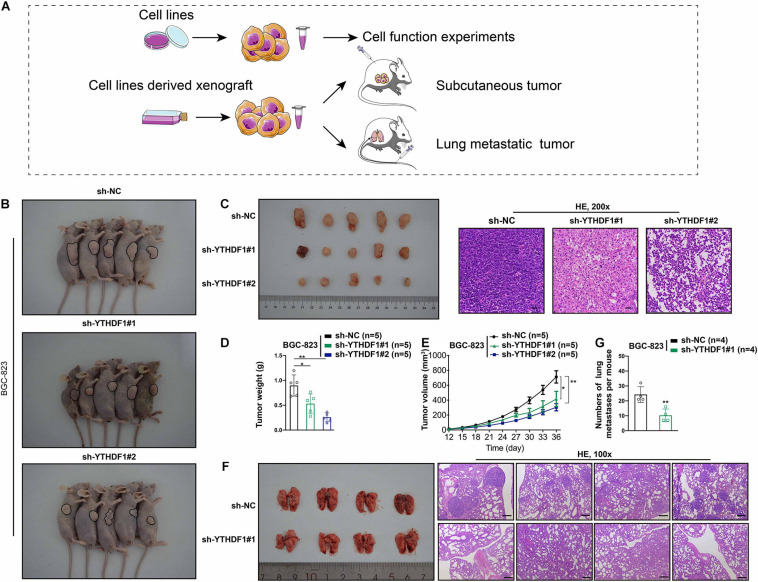
YTHDF1 deficiency inhibits tumor growth and metastasis in vivo. (A) Different systems were applied including GC cell lines and cell line-derived xenograft. (B) Images of the sacrificed nude mice injected with YTHDF1 deficient BGC-823 cells and its control group in mice subcutaneous tumor model (n = 5). (C) (Left) Tumors were dissected from the nude mice of each group and photographed at 36 days after transplantation. (Right) Representative histology images in mice subcutaneous tumor model (n = 5, 200×). Scale bar, 50 μm. (D,E) Tumor weight and the tumor growth curve were measured in YTHDF1 down-expressed cells and its control group. (F) (Left) Images of pulmonary metastases in mice lung metastasis model (n = 4). Black arrows: metastatic nodules. (Right) Representative histology images in mice lung metastasis tumor model (n = 4, 100×). Scale bar, 200 μm. (G) The numbers of lung metastatic nodules in YTHDF1 down-expressed cells and its control group. GC, gastric cancer. Data are shown as means ± S.D. *P < 0.05, **P < 0.01.